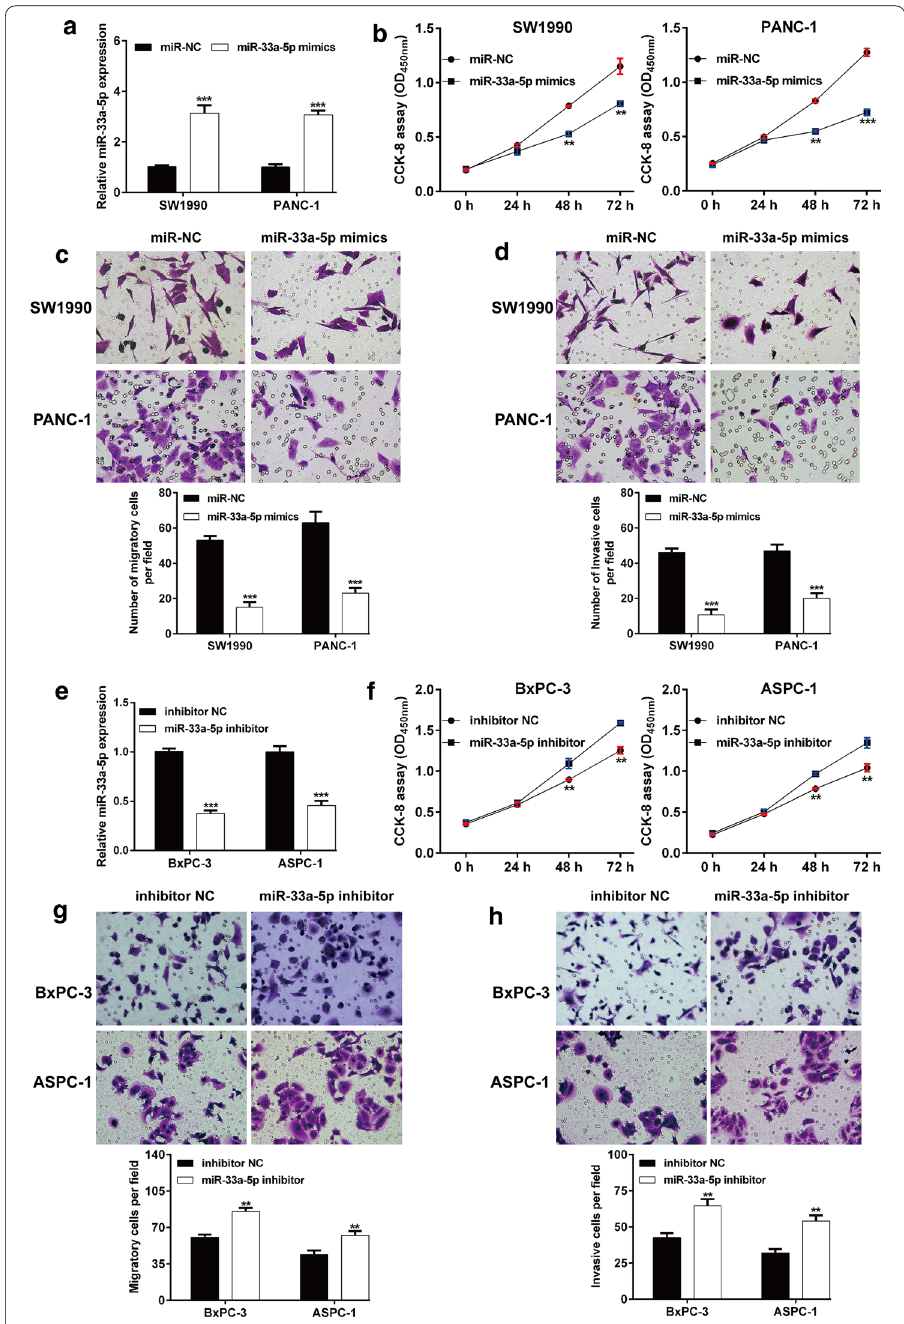
Fig. 2 MiR-33a-5p exerted suppressive effects on PDAC cell proliferation, migration and invasion. A Expression level of miR-33a-5p was assessed by RT-qPCR in SW1990 and PANC-1 cells after transection with the miR-33a-5p mimics or miR-NC. B CCK-8 assay was used to evaluate changes in SW1990 and PANC-1 cell proliferation following transfection with miR-33a-5p mimics or miR-NC. C , D Cell migration and invasion were analyzed in SW1990 and PANC-1 cells following transfection with miR-33a-5p mimics or miR-NC. E BxPC-3 and ASPC-1 cells were transected with the miR-33a-5p inhibitor or miR-NC. After that, the expression level of miR-33a-5p was assessed by RT-qPCR. F Changes in proliferation of transfected BxPC-3 and ASPC-1 cells were evaluated by the CCK-8 assay. G , H Cell migration and invasion were analyzed in transfected BxPC-3 and ASPC-1. ** p < 0.01, *** p < 0.001 vs. miR-NC or inhibitor NC